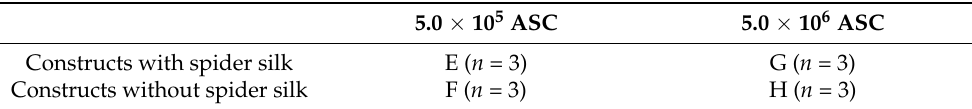
Table 2. Overview of experimental groups for contraction assay with different numbers of adipose derived stromal cells